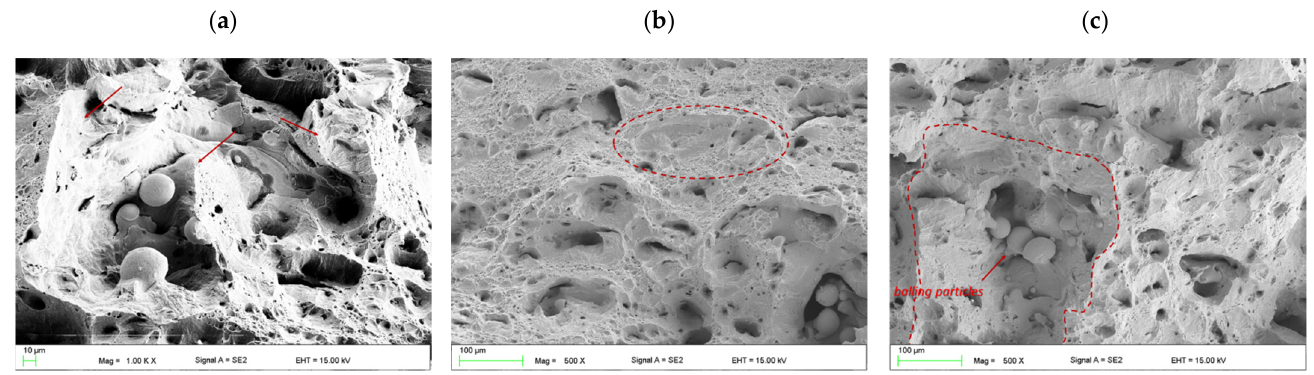
Figure 12. Fractured surface features of the AM maraging steel M789 in solution annealed conditions. Images ( a – c ) are described in the text.